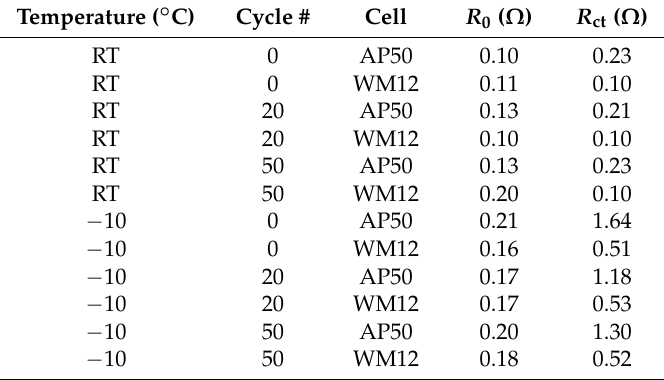
Figure 10. Proposed equivalent circuit model for pouch cells AP50 and WM12. Table 7. Summary of solution resistances ( R 0 ) and charge-transfer resistances ( R ct ) for Cell AP50 and Cell WM12 measured at room temperature (RT) and − 10 °C at different cycles.